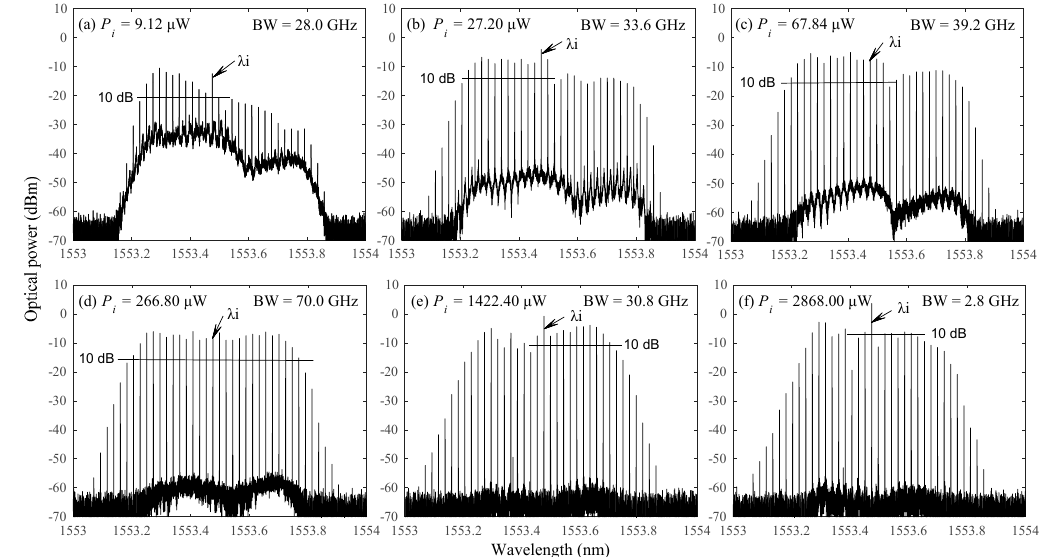
Figure 6. Experimentally measured total-OFC output from a gain-switching VCSEL under optical injection with λ i = 1553.4843 nm and different values of P i , where ( a ) P i = 9.12 μ W, ( b ) P i = 27.20 μ W, ( c ) P i = 67.84 μ W ( d ) P i =266.80 μ W, ( e ) P i = 1422.40 μ W, and ( f ) P i =2868.00 μ W.